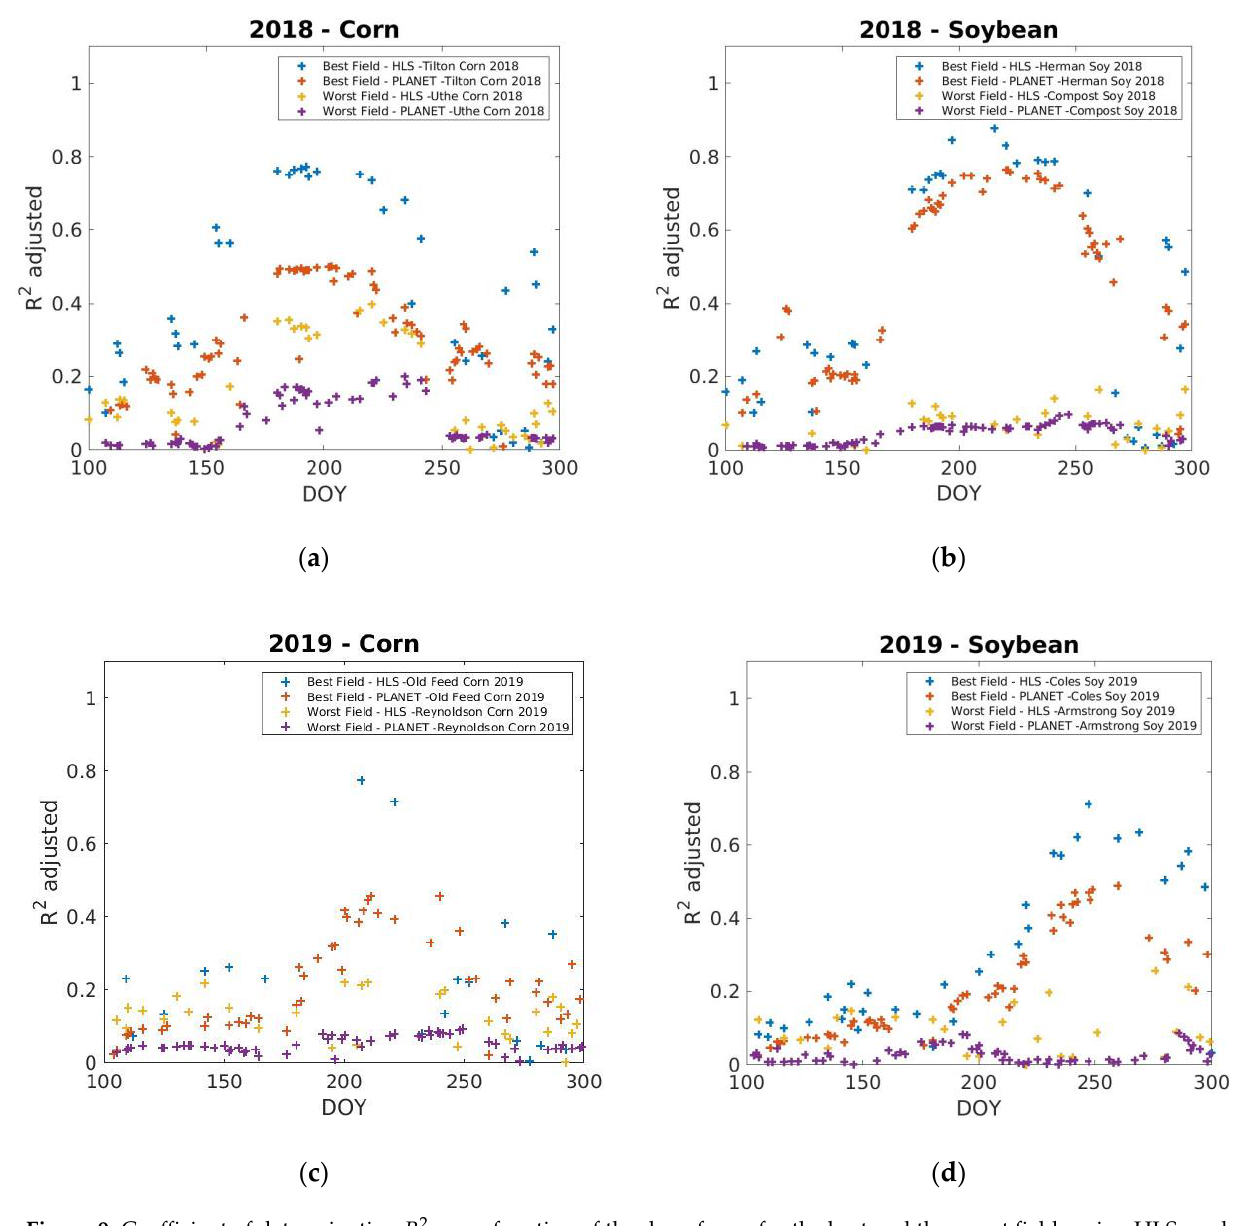
Figure 9. Coefficient of determination R 2 as a function of the day of year for the best and the worst fields using HLS- and adj Planet-derived SR values to correlate with yields: ( a ) corn in 2018; ( b ) soybean in 2018; ( c ) corn in 2019; ( d ) soybean in 2019.